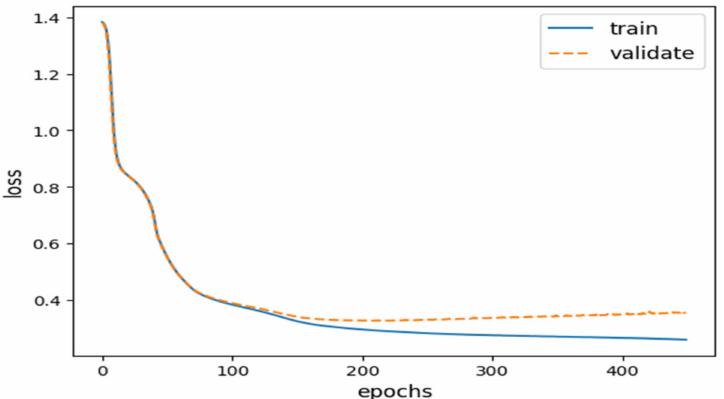
Figure 20. P-MLP training loss value.